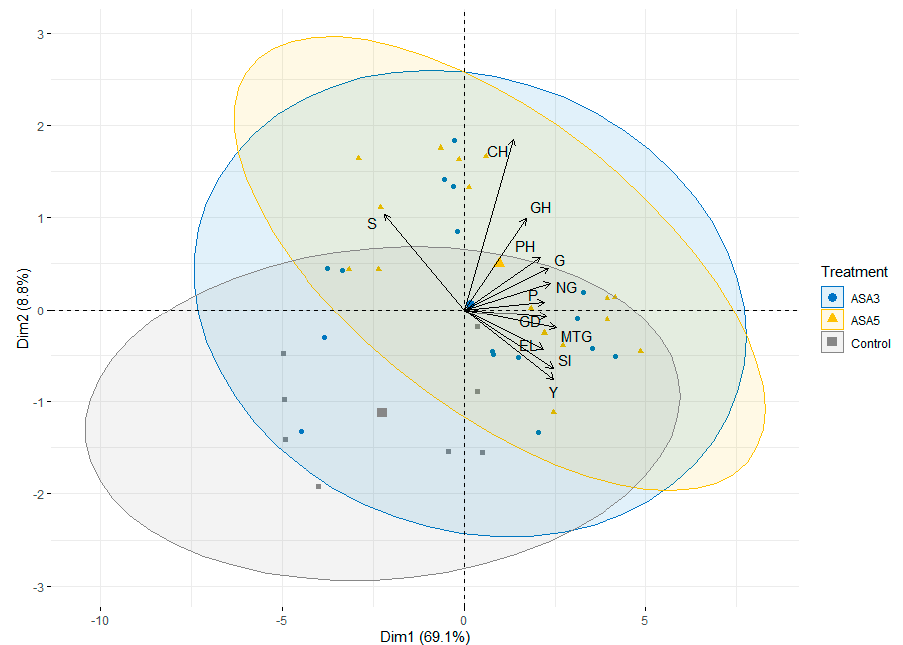
Figure 2. PCA biplot showing the interaction between concentrations of acetylsalicylic acid (ASA) and selected traits in spring wheat broken down by terms of application (T1/T2, T3/T4). PH-plant height; EL-ear length; CH-chlorophyll; NG-number of grains per ear; MTG-mass of a thousand grains; Y-yield; P—proteins in grain; G-gluten in grain; S-starch in grain; SI-sedimentation index; GH-grain hardness index; GD-grain density.